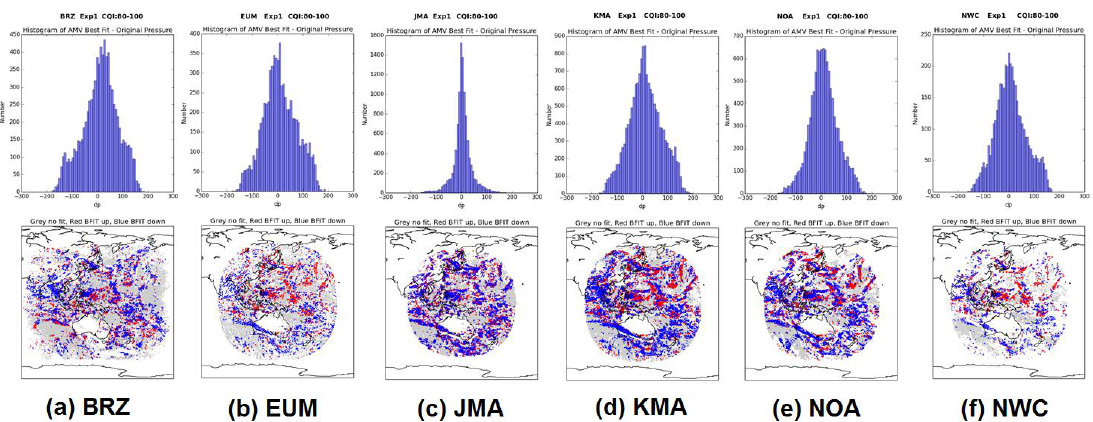
Figure 5. Histogram (upper) and maps (lower) of the difference ‘ AMV best-fit pressure level – AMV pressure level’ for ( a ) BRZ, ( b ) EUM, ( c ) JMA, ( d ) KMA, ( e ) NOA, ( f ) NWC. In the maps, red shows the best-fit pressure at a higher level; blue shows the best-fit pressure at a lower level.